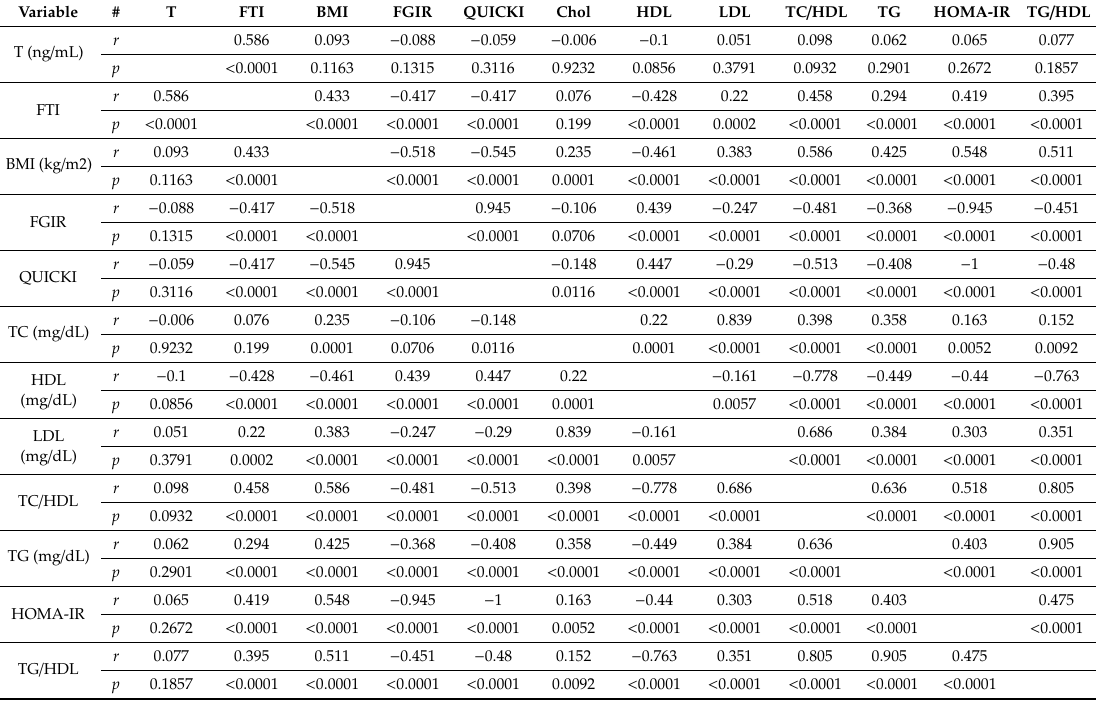
Table 4. Correlation between studied parameters in Group